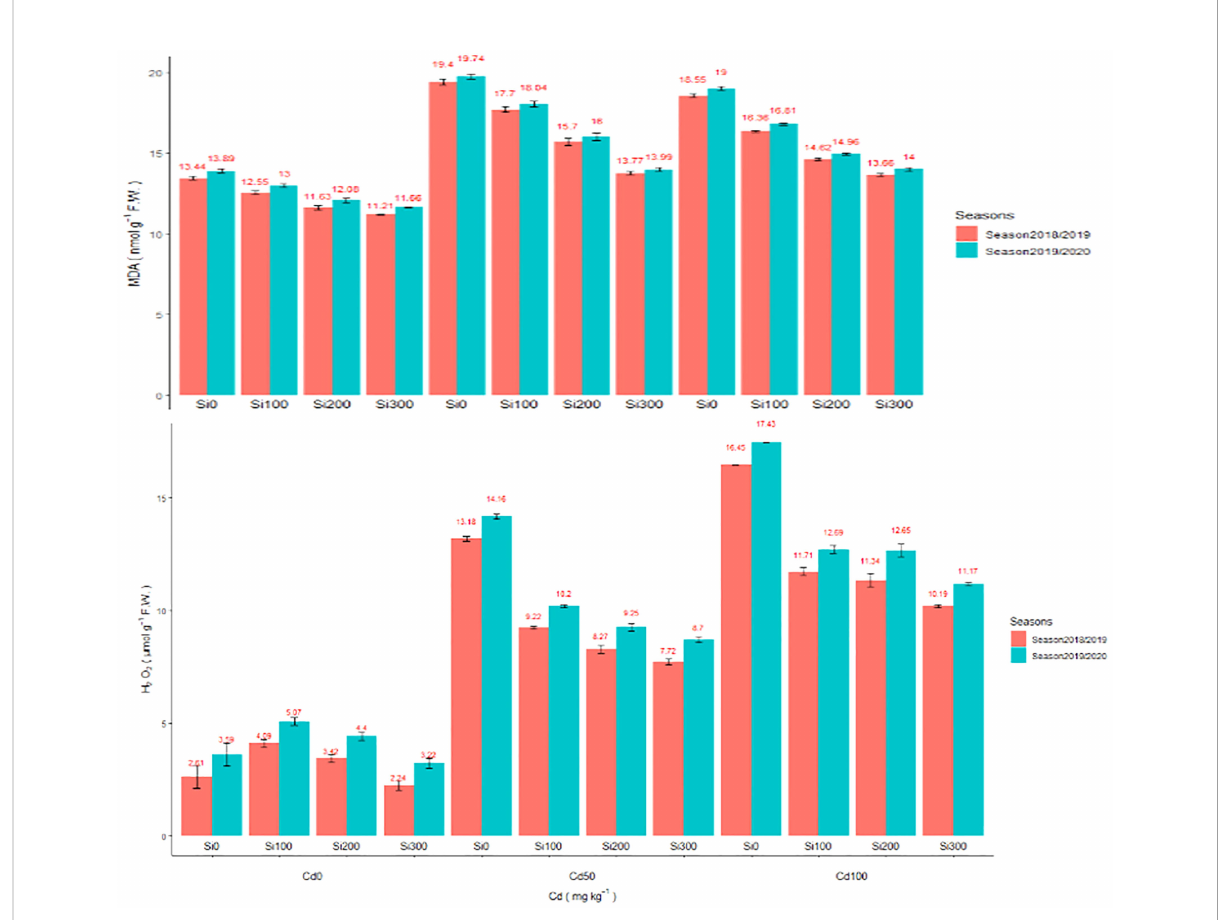
FIGURE 1 (A) Effect of foliar application of Silicon on pea MDA (nmol g-1 F.W.) grown in different concentrations of cadmium (Cd) during 2018/2019 and 2019/2020 growing seasons. (B) Effect of foliar application of Silicon on H 2 O 2 µmol g – 1 FW grown in different concentrations of cadmium